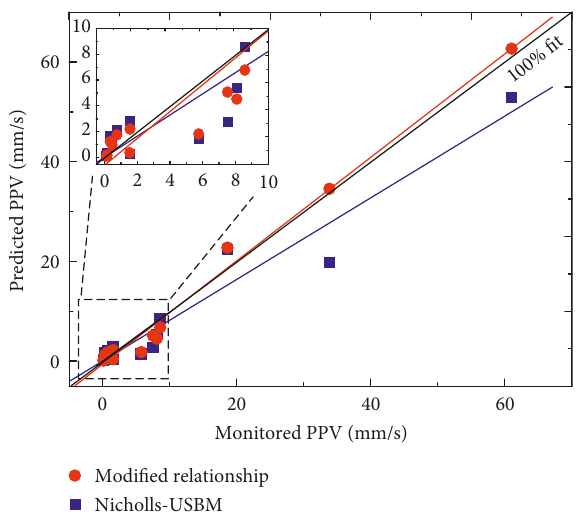
Figure 13: Comparison between predicted and monitored PPV.